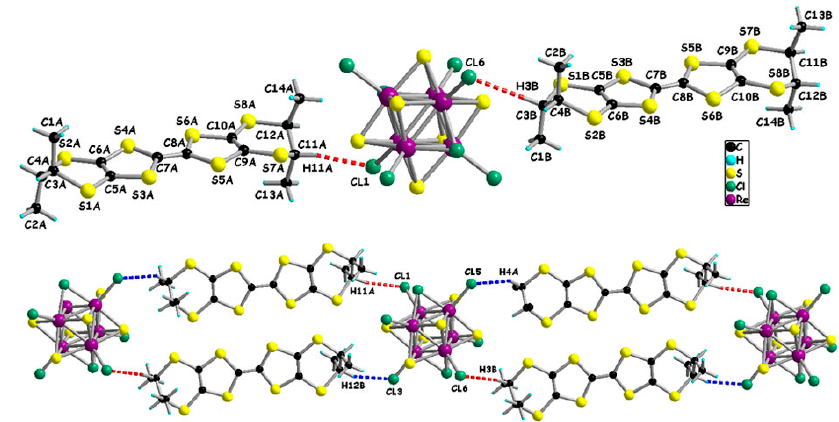
Figure 2. Two independent donor molecules and one rhenium cluster in the structure of [( S )- 1 ] 2 ·Re 6 S 6 Cl 8 together with a partial numbering scheme ( top ); detail of the hybrid organic-inorganic layer with